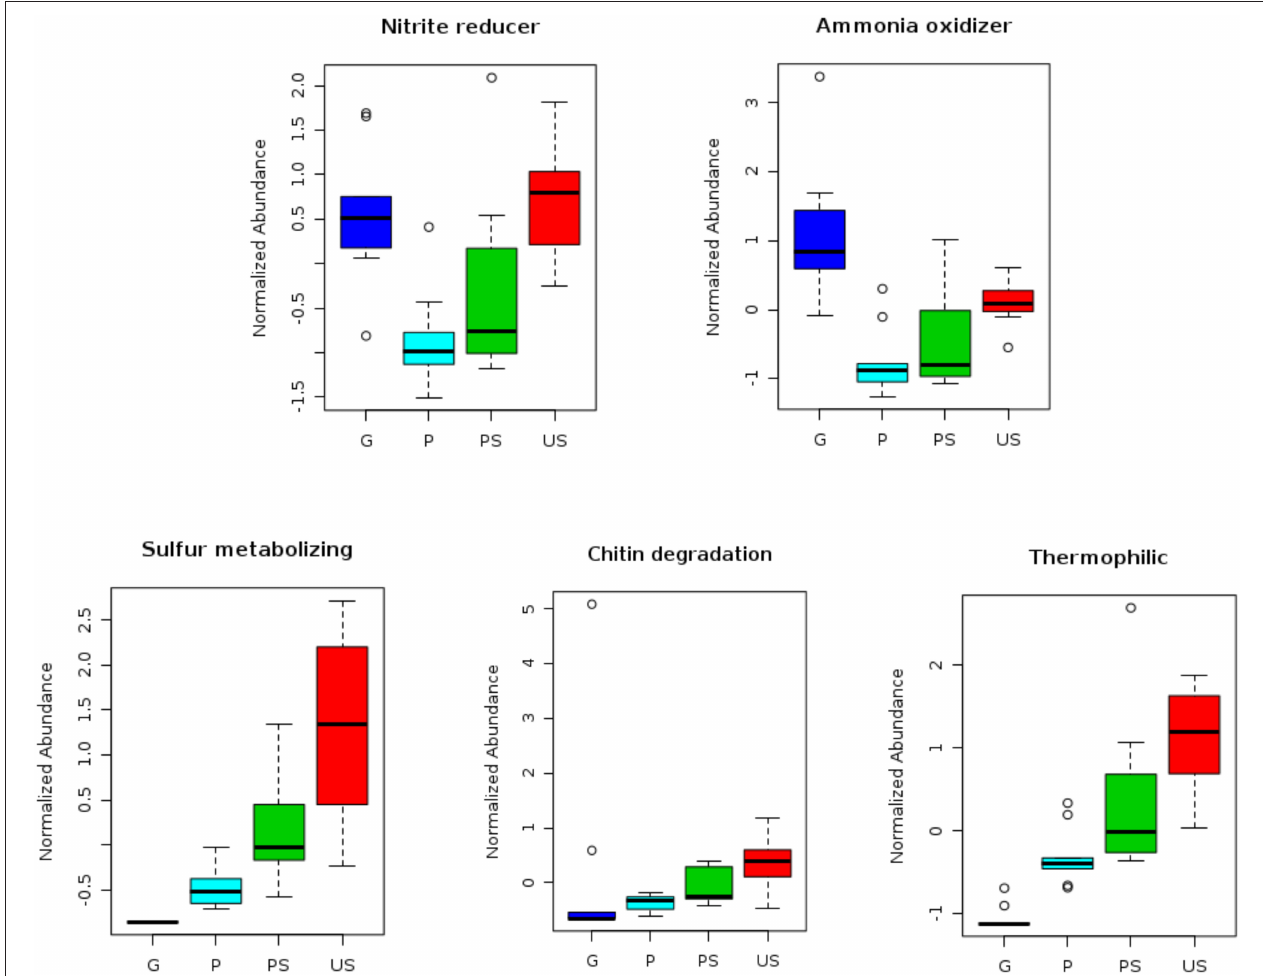
FIGURE 4 | Outcomes of analyses performed with METAGENassist. Different functional categories showing significant differences among samples are shown. Blue, cyan, green, and red boxplots represent the normalized abundance of each category in G, P, PS, and US samples, respectively.